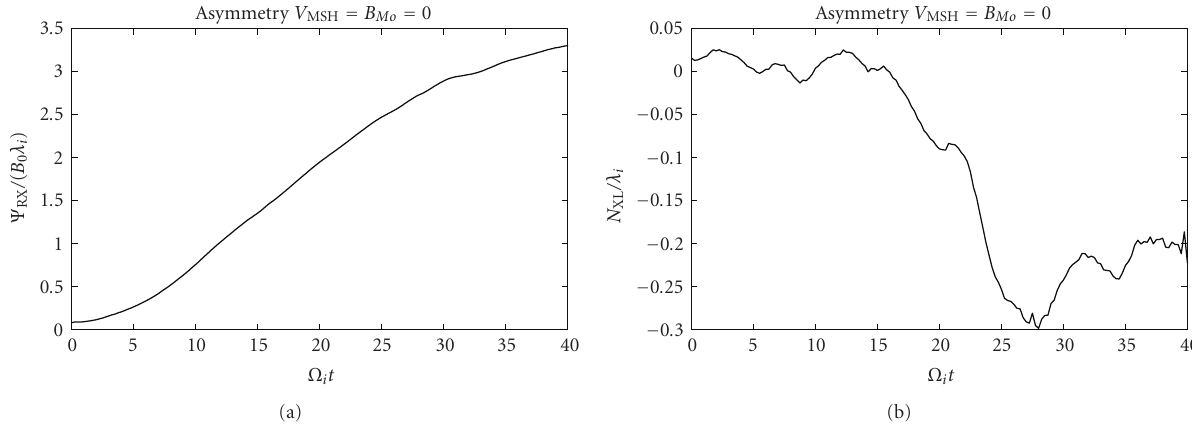
Figure 3: The result of V MSH = B Mo = 0 case with density asymmetry. Temporal developments of (a) the reconnected flux and (b) N - coordinate of the X-line are shown. The X-line position shifts to the magnetospheric (negative N ) side between t = 15 and 30.